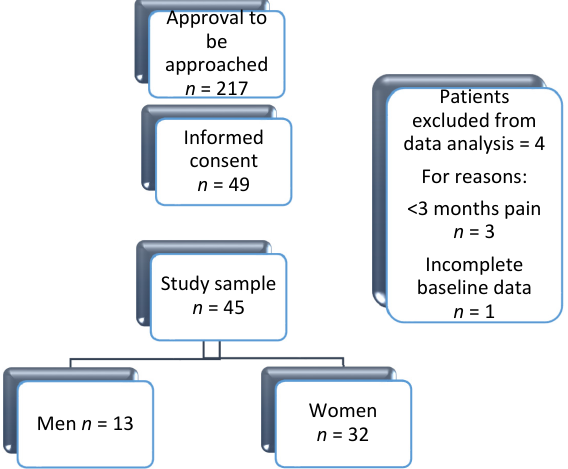
Figure 2. Flowchart of the study sample.